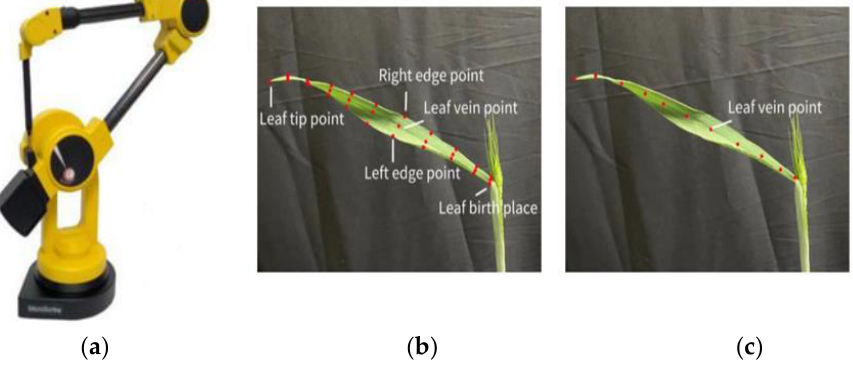
Figure 1. Data acquisition instrument and data acquisition schematic [22] . ( a ) The 3D digital data acquisition instrument; ( b ) leaf surface; ( c ) leaf vein